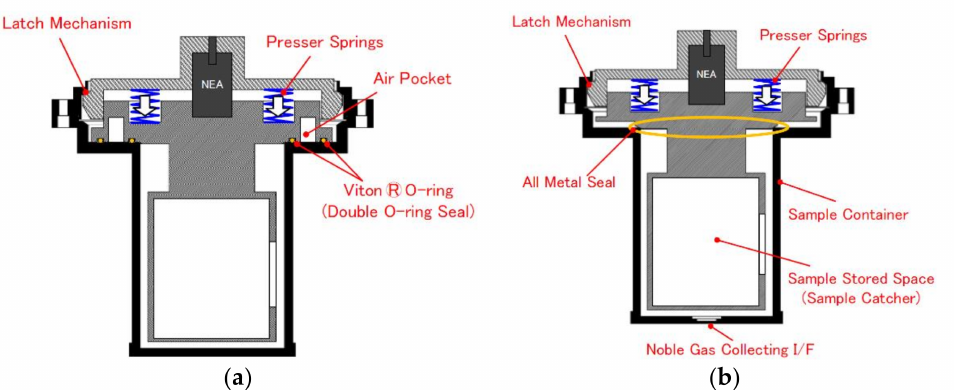
Figure 2. Sample Container concepts developed for the Hayabusa missions: ( a ) Hayabusa 1, foreseen with two Viton O-rings, ( b ) Hayabusa 2, foreseen with a metallic gasket [18].